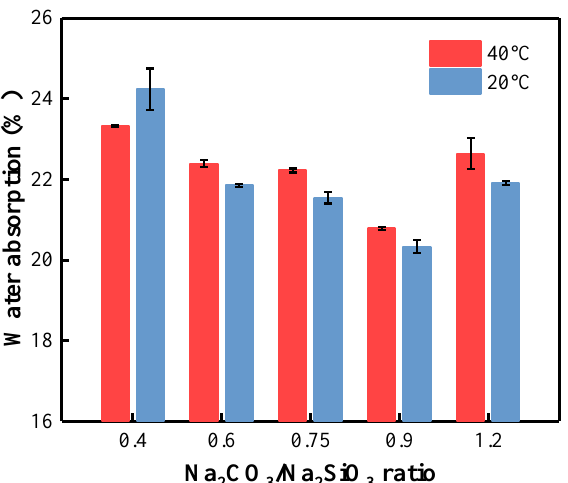
Figure 14. Water absorption of AAM pastes with different C/S ratios cured at 40 °C and 20 °C.